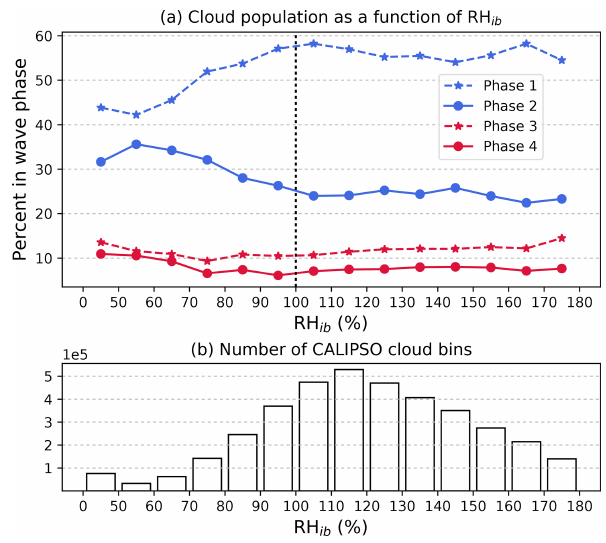
Figure 11. (a) Percentage of TTL clouds inside each wave phase as a function of background relative humidity with respect to ice (RH ib ). (b) Number of CALIPSO Cloud Profile bins in each RH ib